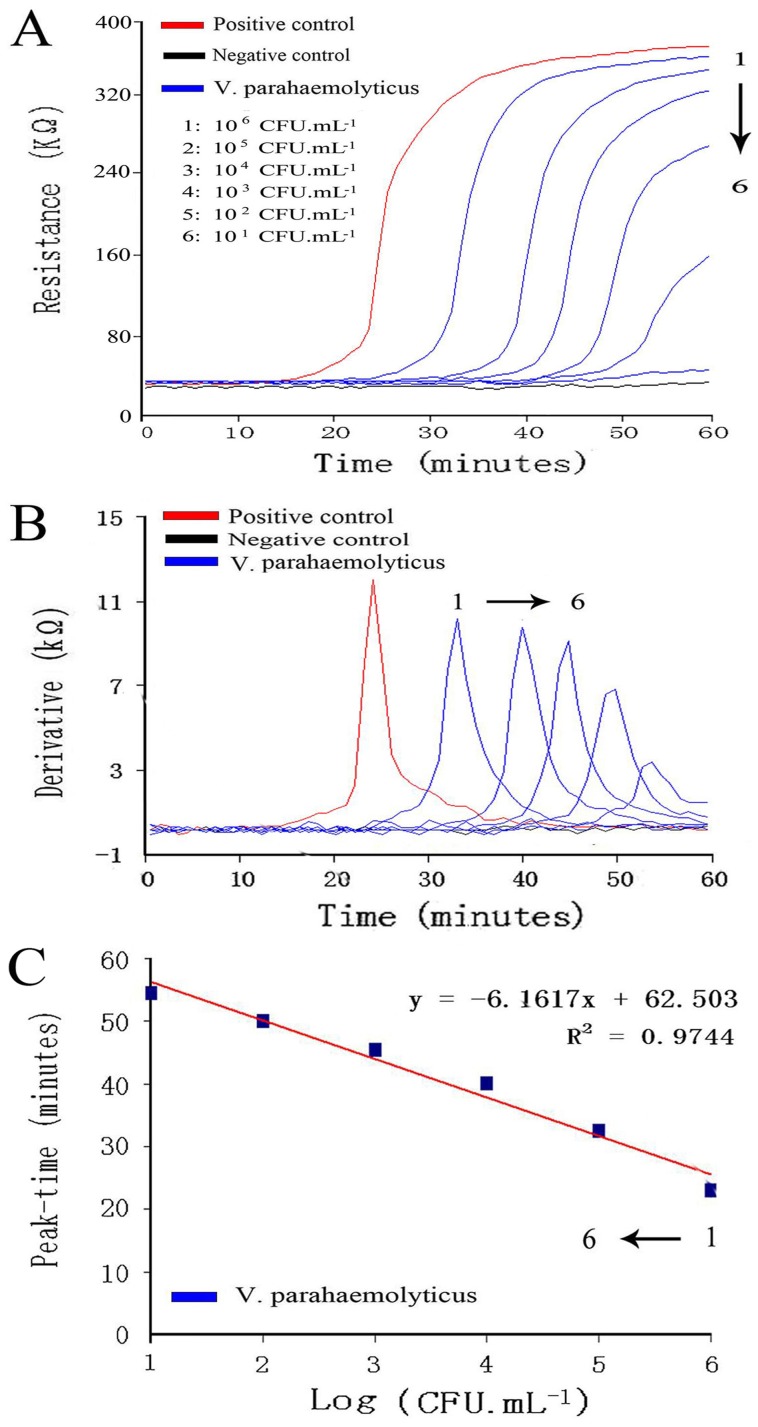
Sensitivity and regression analyses of the real-time resistance measurement.A. The real-time resistance curve of V. parahaemolyticus in a concentration gradient. B. The derivative analysis of the real-time resistance measurement of V. parahaemolyticus. C. The regression analysis of the real-time resistance measurement of V. parahaemolyticus. Three samples of the same bacterial concentration were measured twice and all values were recorded as mean(n = 6).